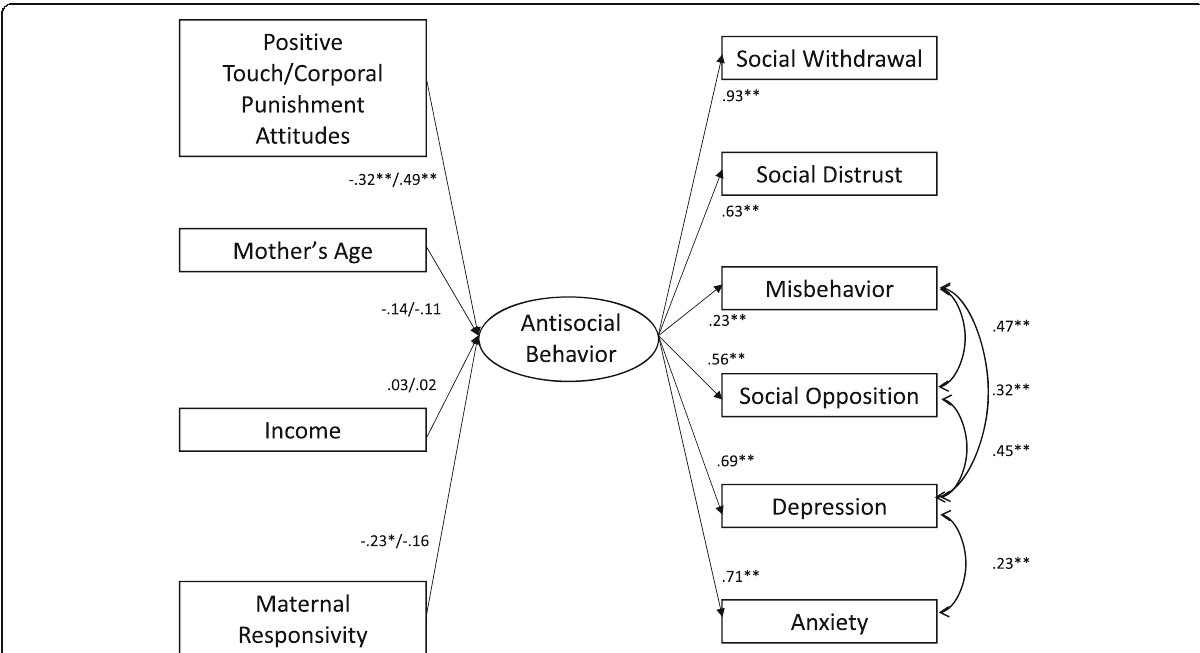
Fig. 2 Antisocial behavior predicted by touch attitudes, separate models. All coefficients are standardized. Coefficients for positive touch and corporal punishment attitudes are separated by “ / ” for all predictors. Latent variable loadings and covariances are constrained in both models and are the same for both models. Positive touch attitudes predicting antisocial behavior fit indices: robust χ 2 (34) = 56.791, p = .008; robust CFI = .942; RMSEA = .066, 90% CI = [.035, .093]; SRMR = .055. Corporal punishment attitudes predicting antisocial behavior fit indices: robust χ 2 (34) = 65.569, p = .001; robust CFI = .921; RMSEA = .077, 90% CI = [.051, .103]; SRMR =